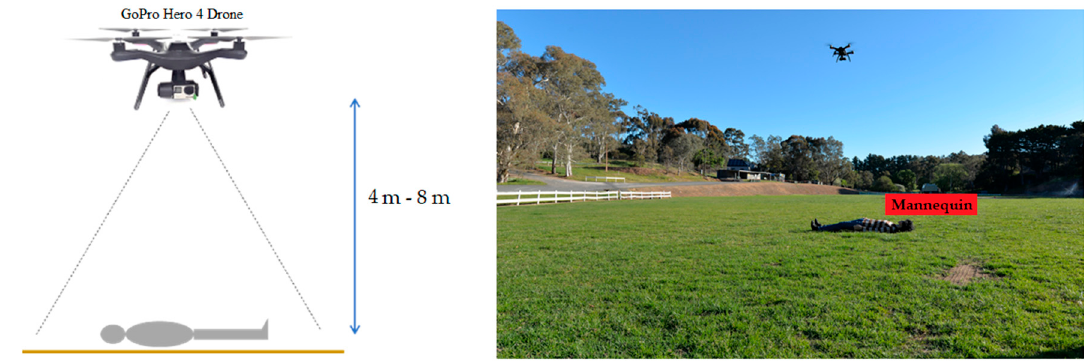
Figure 1. Experimental setup of the proposed life detector system.